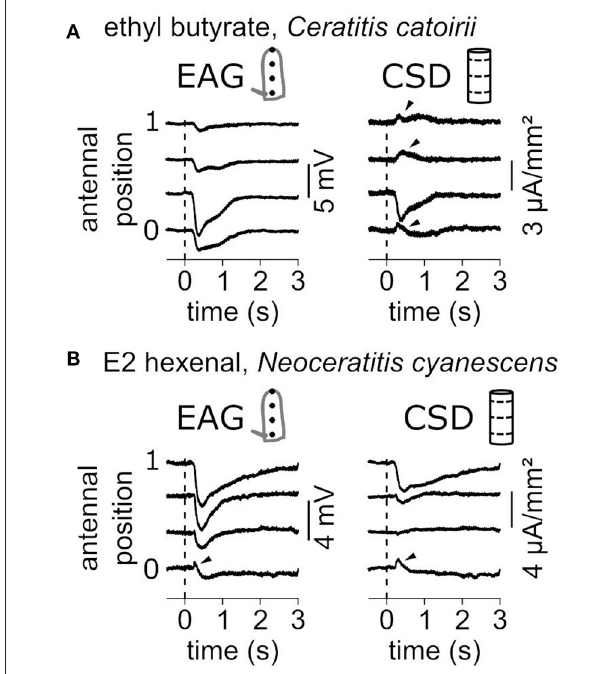
FIGURE 7 | Current sources are occasionally observed. (A) Antennal response of a C. catoirii female to puffs of ethyl butyrate. Left: The EAG responses were recorded at four antennal positions. The dash line indicated the onset of stimulation. Right: The CSD responses were estimated from the EAG recordings. Apparent current sources are pinpointed with arrowheads. (B) Antennal response of a N. cyanescens female to puffs of E2 hexenal. Same conventions as in (A) . A transient positive response in the EAG signal is also